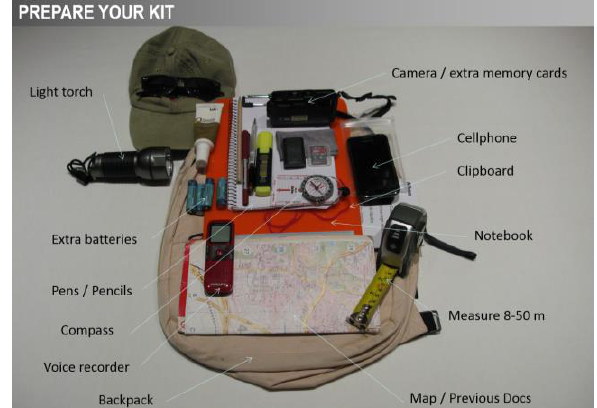
Figure 5. Basic kit for emergency documentation. Such kits